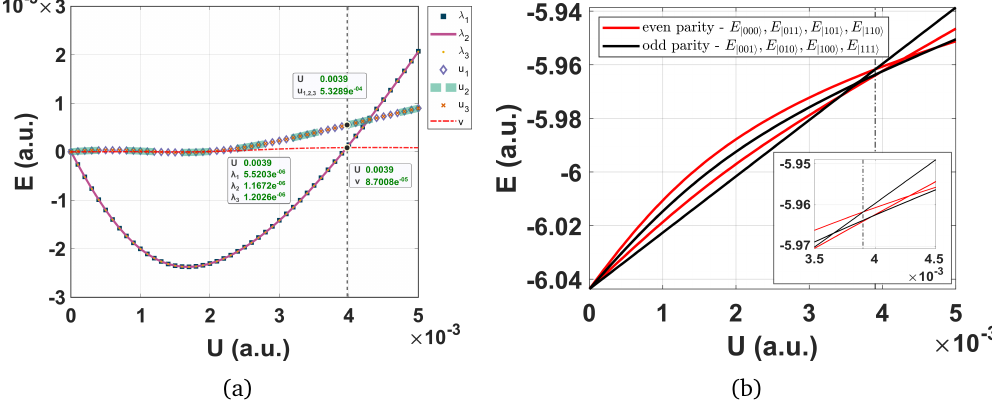
Figure 9: The SYK point parameters for three-complex-fermion model for a N = 10 = 3, n = 4, sec- site Kitaev chain model (first non-topological segment: n nt1 1 nt1 2 = 7, n = 8) obtained using the approxi- ond non-topological segment: n nt2 1 nt2 2 mate method for SYK point search, i.e., method (i) described in Section 6.5 are: = 0.0100, µ = 0.0100, µ = 0.0100, µ = 3.0001, t = 0.0144, ∆ = 0.0104, µ t1 t2 t3 nt1 µ = 3.0001, U = 0.0039. (a), At the SYK point (shown by black dotted line-cut) nt2 λ = 5.5203 e − 06 , λ = 1.1672 e − 06 , λ = 1.2026 e − 06 , u = u = u = 5.3289 e − 04 1 2 3 12 13 23 and v = 8.7008 e − 05 (b), At the SYK point, there is degeneracy between one even and one odd parity level. Focusing on the line-cut in the inset, the bottom most line (red) consists of three degenerate even parity energy levels and the second line from bottom (black) consists of three degenerate odd parity energy levels, the two intersecting lines on the top are a single odd and a single even parity energy level